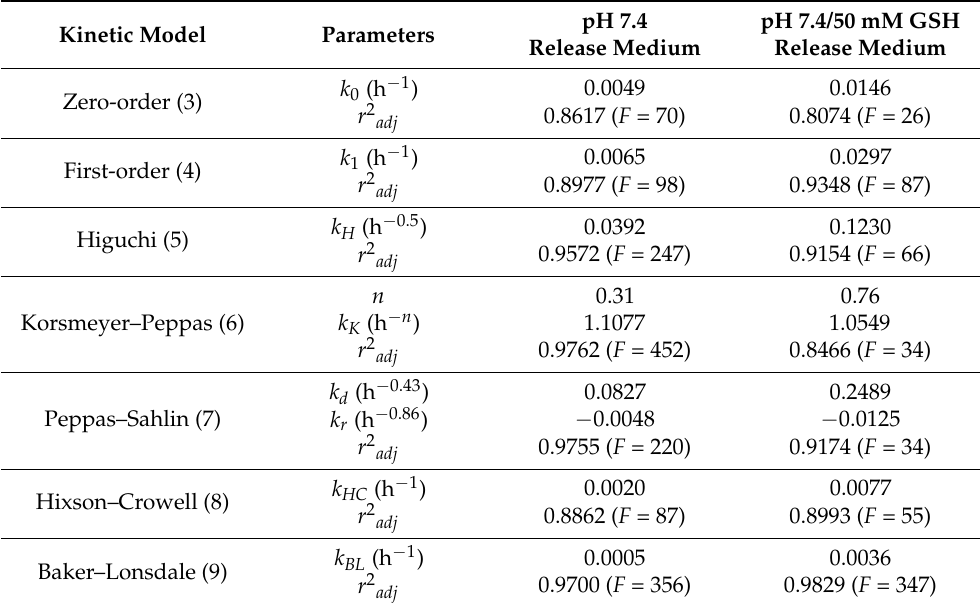
Table 2. Mathematical modeling and drug release kinetics from drug-loaded (10 wt.% Dox · HCl)